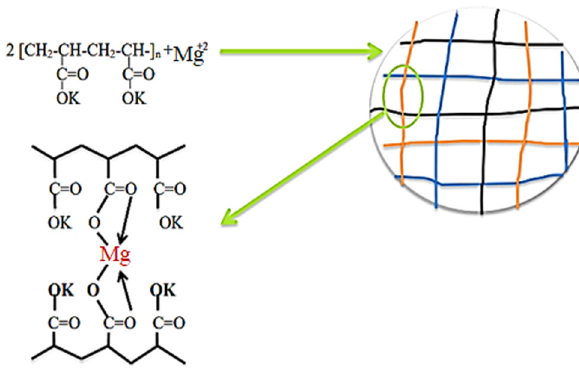
Figure 2: Mg - PA SAP